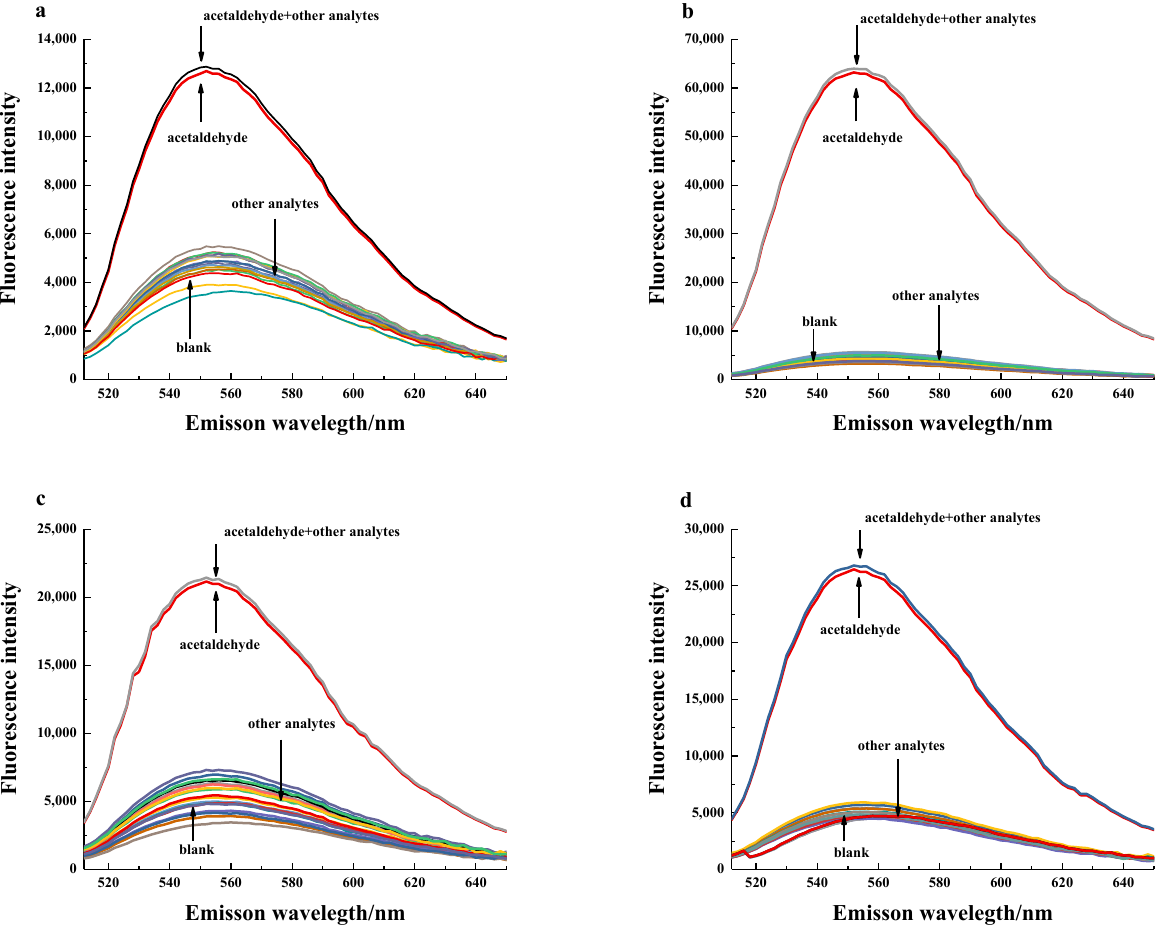
Figure 6. ( a ) Fluorescence spectrum of anti-interference analysis of beer with BRM. ( b ) Fluorescence spectrum of anti-interference analysis of liquor with BRM. ( c ) Fluorescence spectrum of anti-interference analysis of Huangjiu with BRM. ( d ) Fluorescence spectrum of anti-interference analysis of wine with BRM. The concentration of acetaldehyde and other analytes are shown in Table S5.